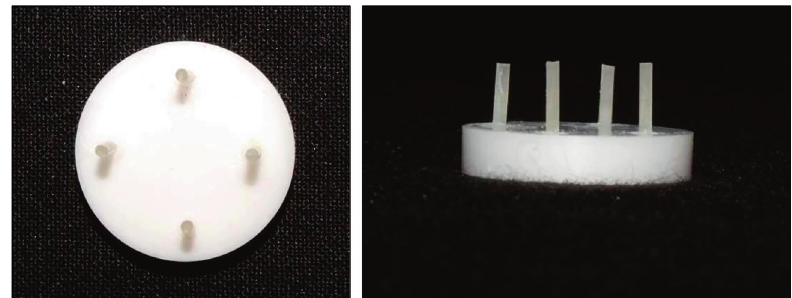
Figure 1: Specimen with resin cement cylinders on zirconia discs.